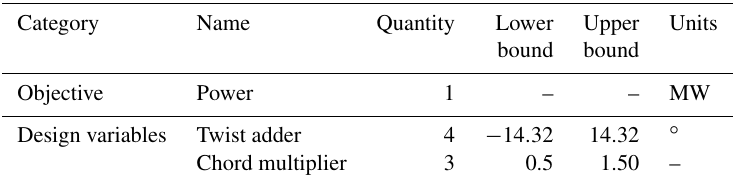
Figure 5. Baseline and optimized chord and twist distributions. Table 1. Optimization problem formulation for the unconstrained power maximization